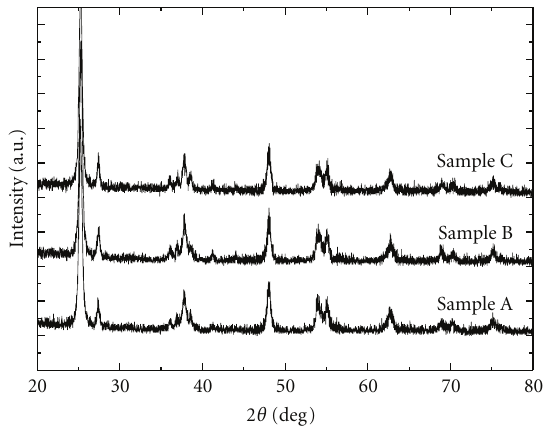
Figure 4: XRD patterns for TiO 2 dispersions with di ff erent disper- sivity.